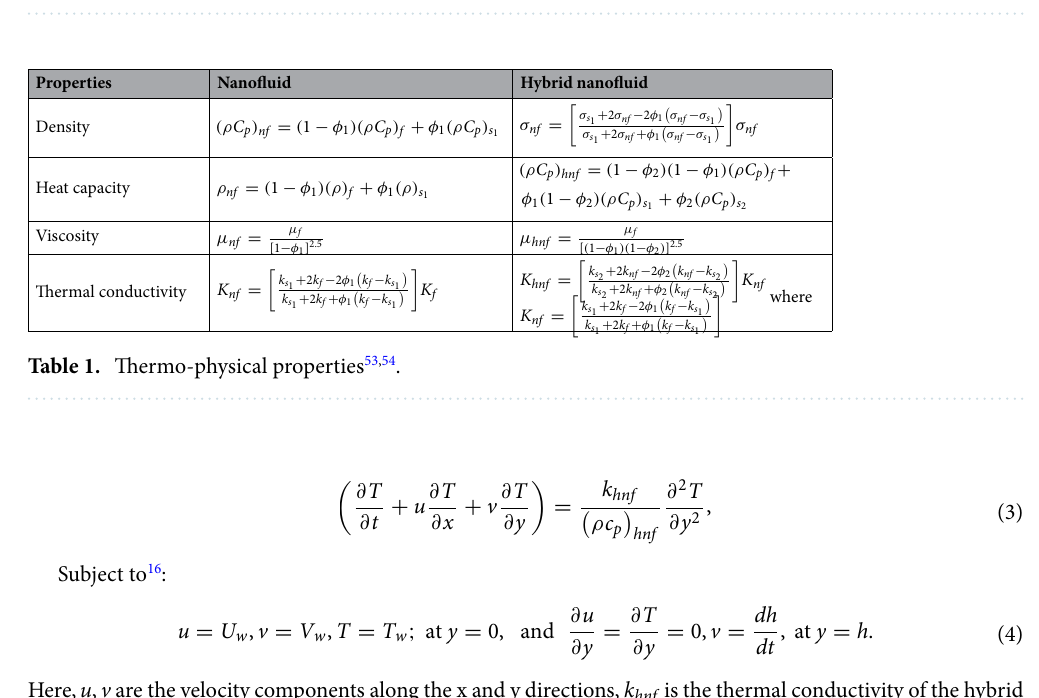
Figure 1. Geometry of the model 5 .